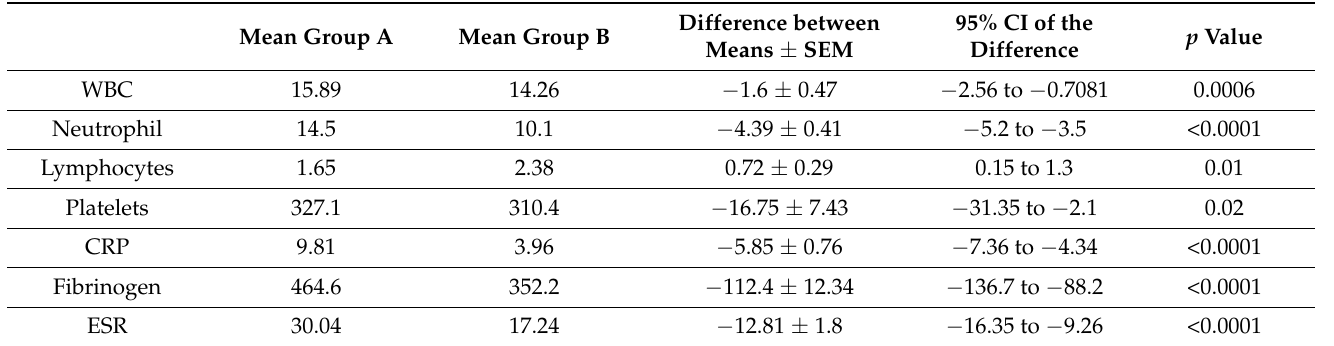
Table 1. Comparative analysis of paraclinical data obtained from hemogram and inflammatory samples.